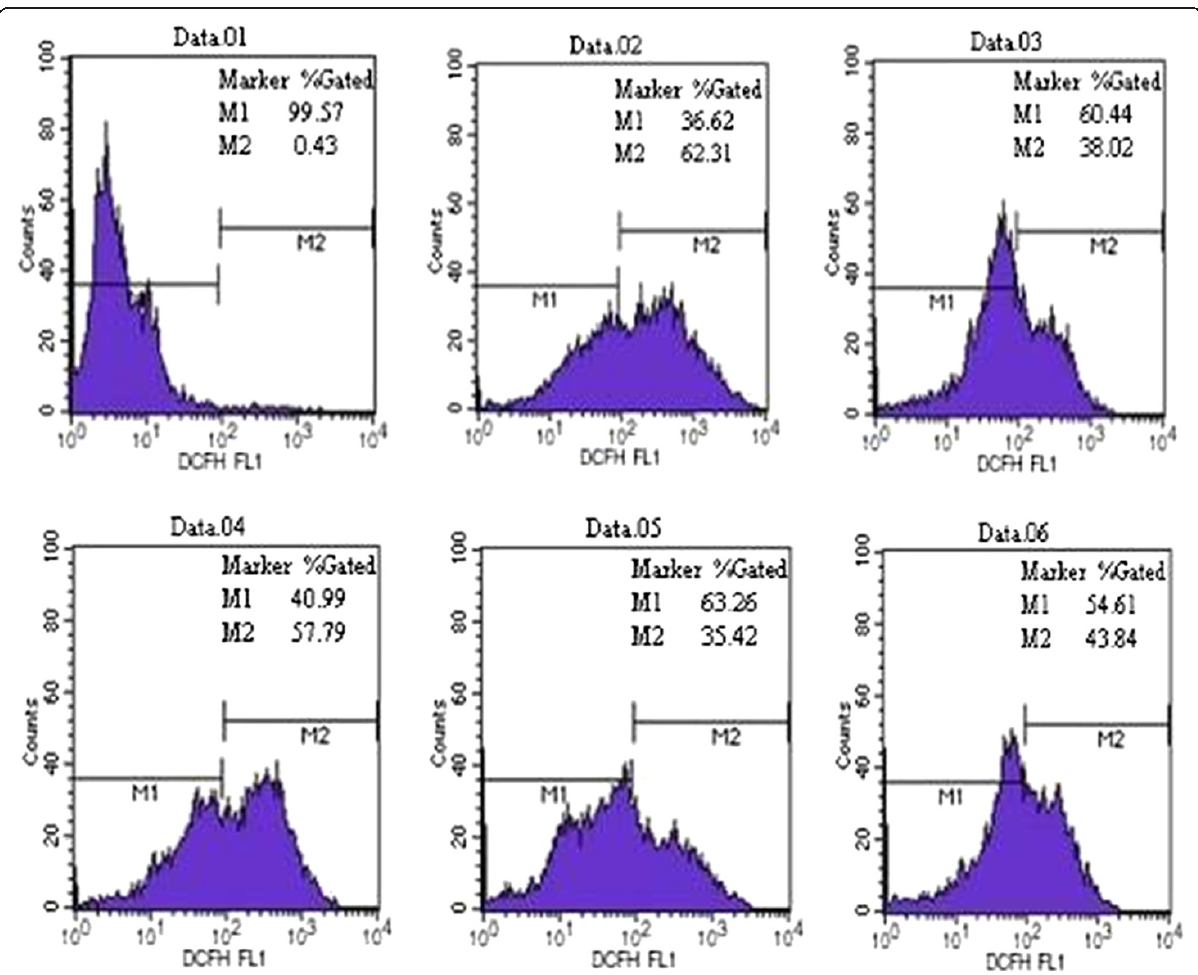
Figure 2 EGCG attenuates intracellular ROS production after MPP + -induced oxidative stress. PC12 cells were treated as indicated by the various groups. Data. 01: negative control, control group without DCFH-DA; Data.02: positive control, control group with DCFH-DA and rosup; Data.03: control group with DCFH-DA; Data.04: 500 μ M MPP + ; Data.05: 10 μ M EGCG; Data.06: 500 μ M MPP + and EGCG 10 μ M. Intracellular ROS production was determined by DCFH-DA